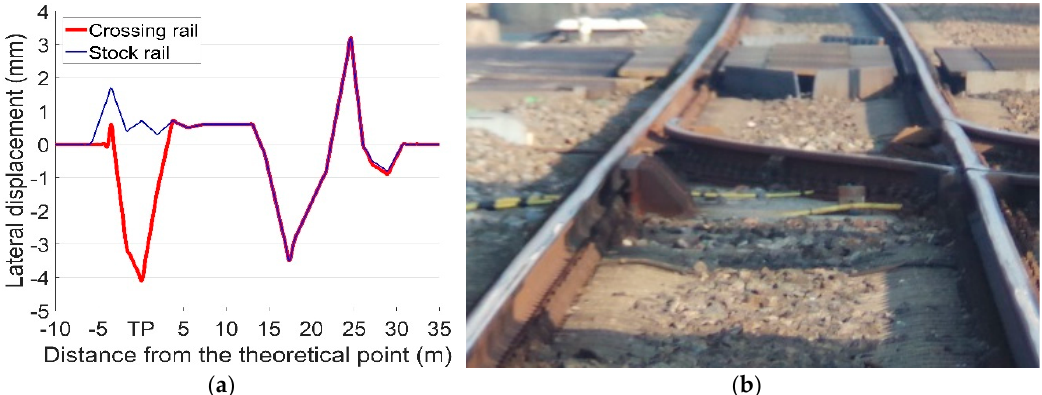
Figure 20. ( a ) Temperature-initiated rail lateral displacement in FE simulation (adapted from Figure 11.15 in [23]); ( b ) the monitored crossing. 11.15 in [23]); ( b ) the monitored